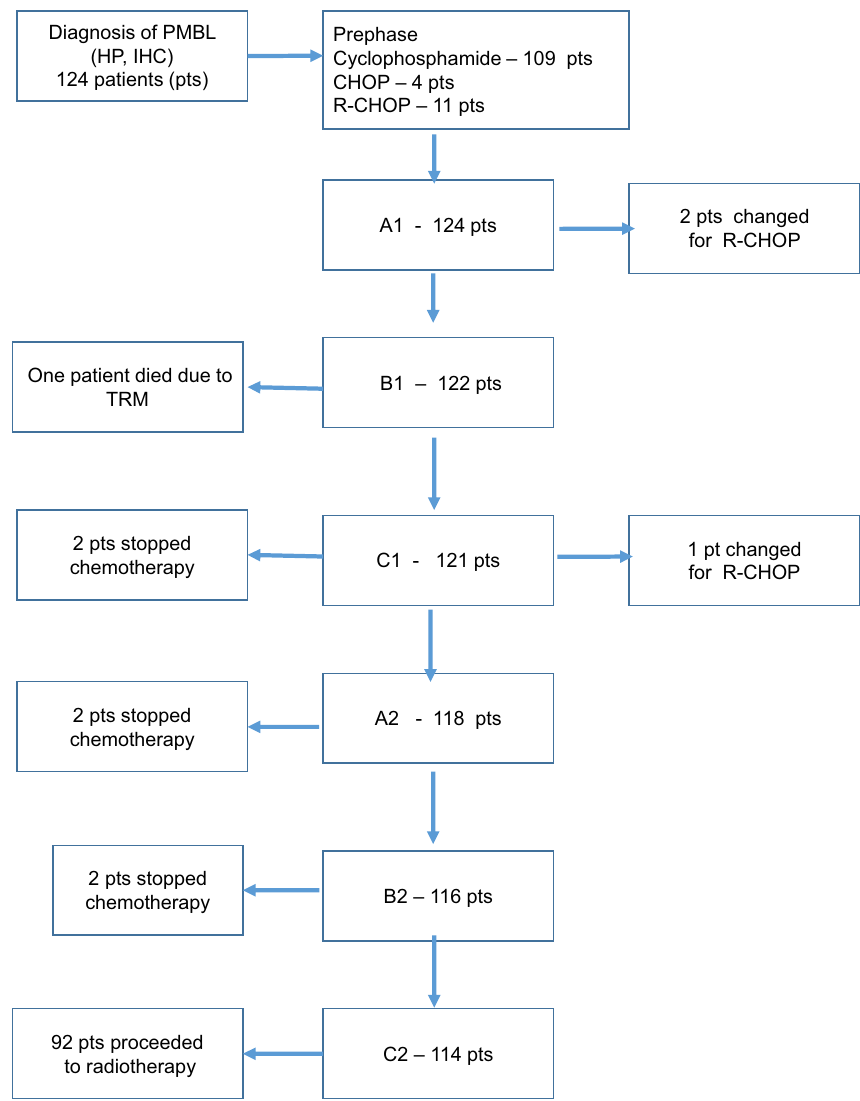
Figure 1. GMALL/B-ALLL/NHL2002 – treatment disposition. A1, B1, C1, A2, B2, C2 – cycles of GMALL/B- ALL/NHL2002 17